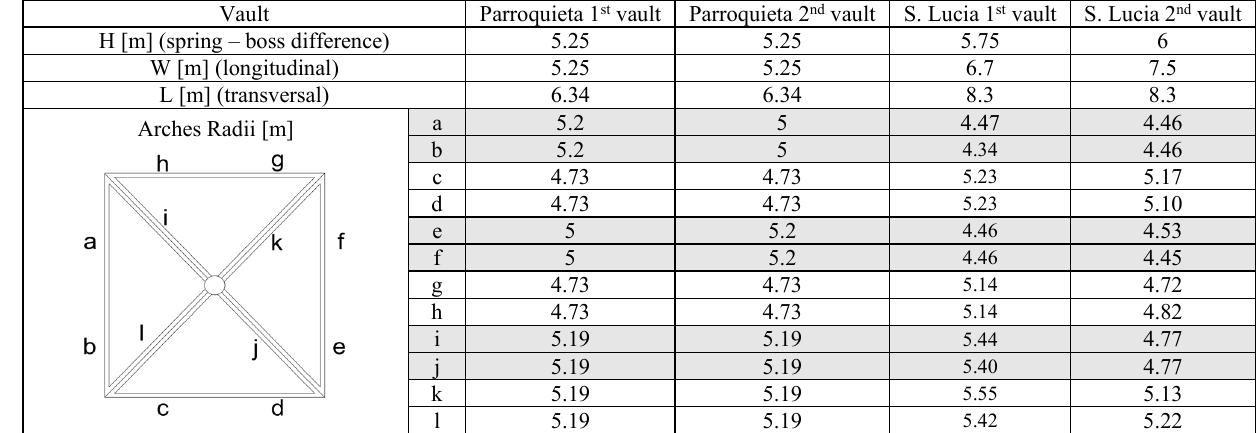
Table 1 . Dimensional data of the vaults and arches radii, the coupled arches are enlightened in grey. All dimensions are in meters.